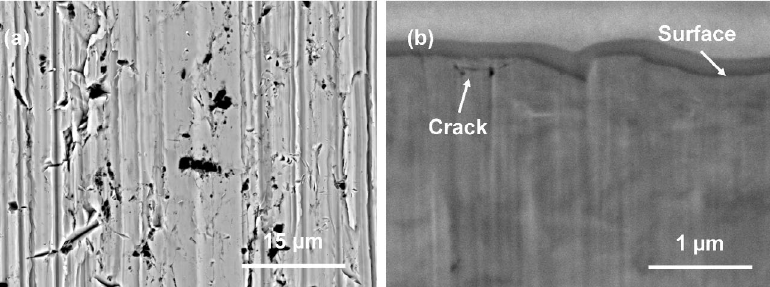
Fig. 10 Pin after testing with the 13 µm slurry at 400 mm/s: (a) SEM image of the worn surface; (b) cross-sectional SEM image of the worn